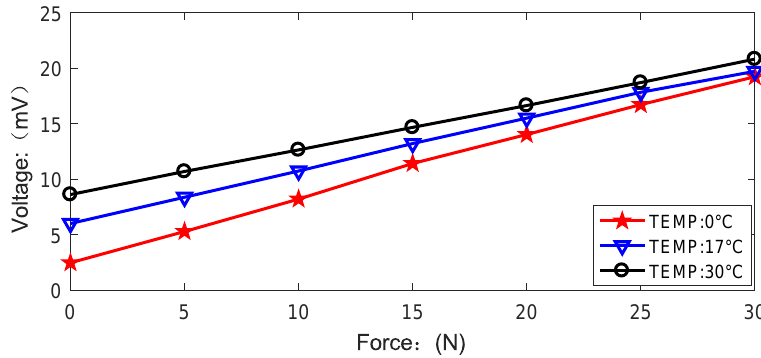
Figure 19. The diagram of UTFS output under different